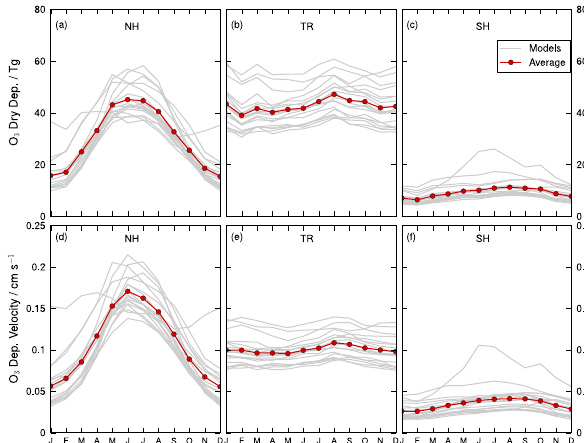
Figure 1. Total monthly O 3 dry deposition (top, a – c ) and monthly average O 3 deposition velocity (bottom, d – f ) for 15 models partic- ipating in the TF HTAP model intercomparison project. Modelled monthly total O 3 dry deposition is shown for the Northern Hemi- sphere extra-Tropics 30–90 ◦ N (a, d) , Tropics 30 ◦ N–30 ◦ S (b, e) , and Southern Hemisphere extra-Tropics 30–90 ◦ S (c, f)